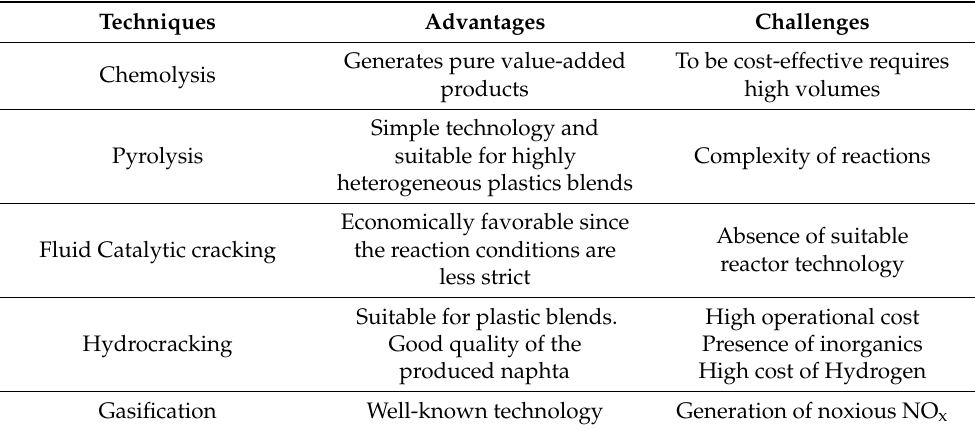
Table 3. Summary of some chemical recycling techniques for plastic waste, incorporating their advantages and challenges